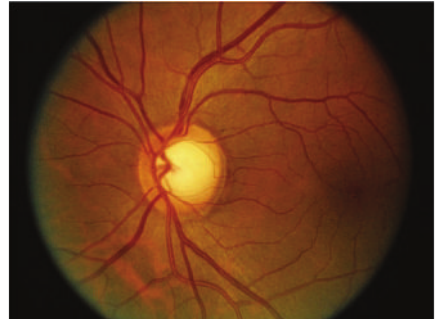
Figure 1: Optic disc in fundus image